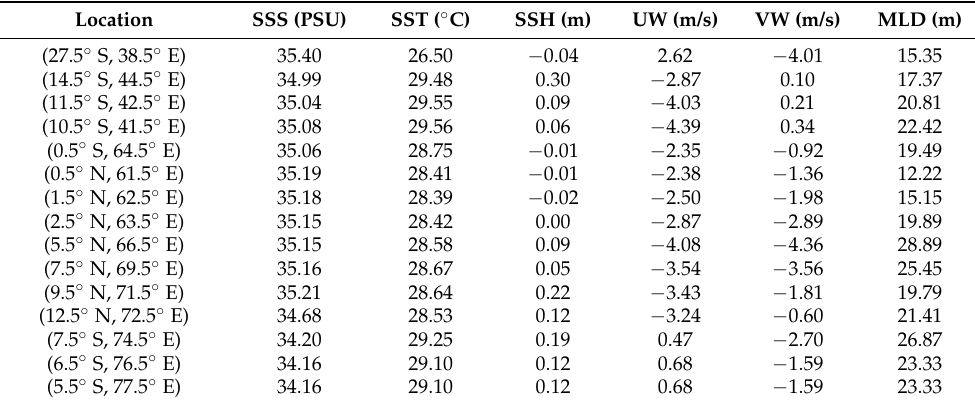
Table 2. Samples of the ocean datasets in January